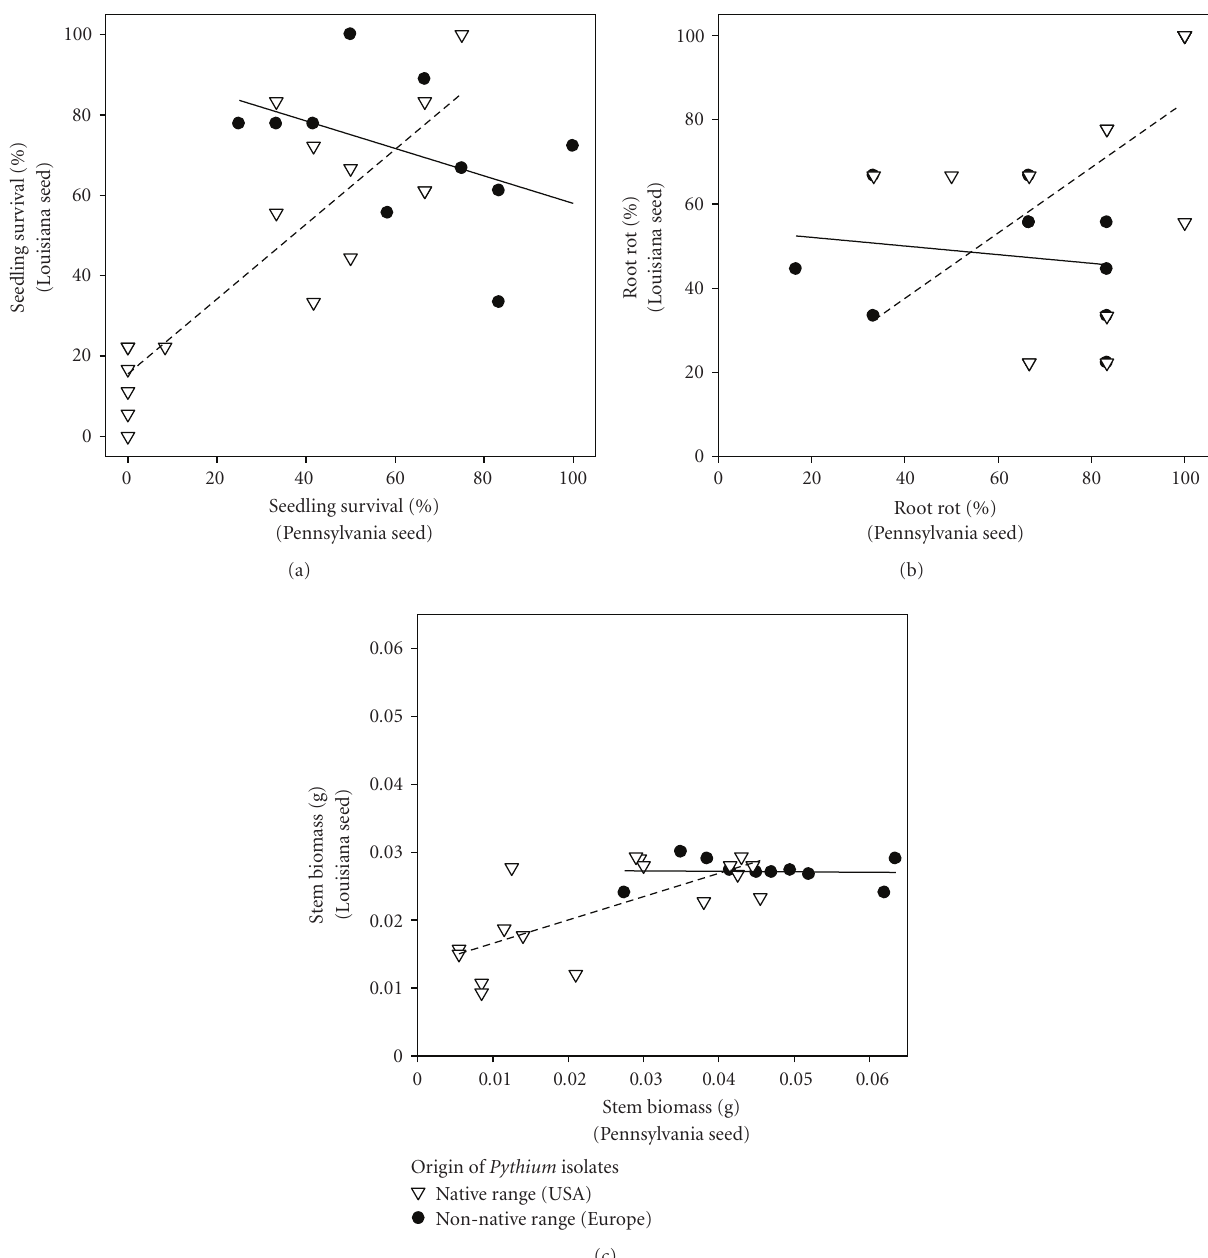
Figure 2: E ff ect of isolates of Pythium spp., associated with Prunus serotina trees in their native ( ∇ : 17 isolates from USA) and nonnative ranges ( • : 10 isolates from western Europe), on the survival, root rot, and stem biomass of P. serotina seedlings from two portions of its native range, Louisiana and Pennsylvania, USA. Each symbol represents the average response of experimental units to a given isolate while interacting with seedlings from either Pennsylvania seed ( n = 2 vessels per isolate) or Louisiana seed ( n = 3 vessels per isolate). Best fit regression lines are shown and the hatched lines correspond with data for isolates from the native range. Each experimental vessel contained only one isolate and seedlings from only a single seed source. Some data points